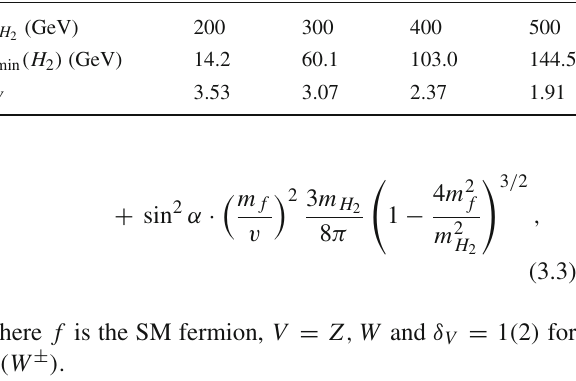
Table 1 First two rows are the masses and decay widths of the H 2 for four benchmark points in the FDM model. The last row gives the g V in the VDM model which produce the (cid:3) min ( H 2 ) in the second